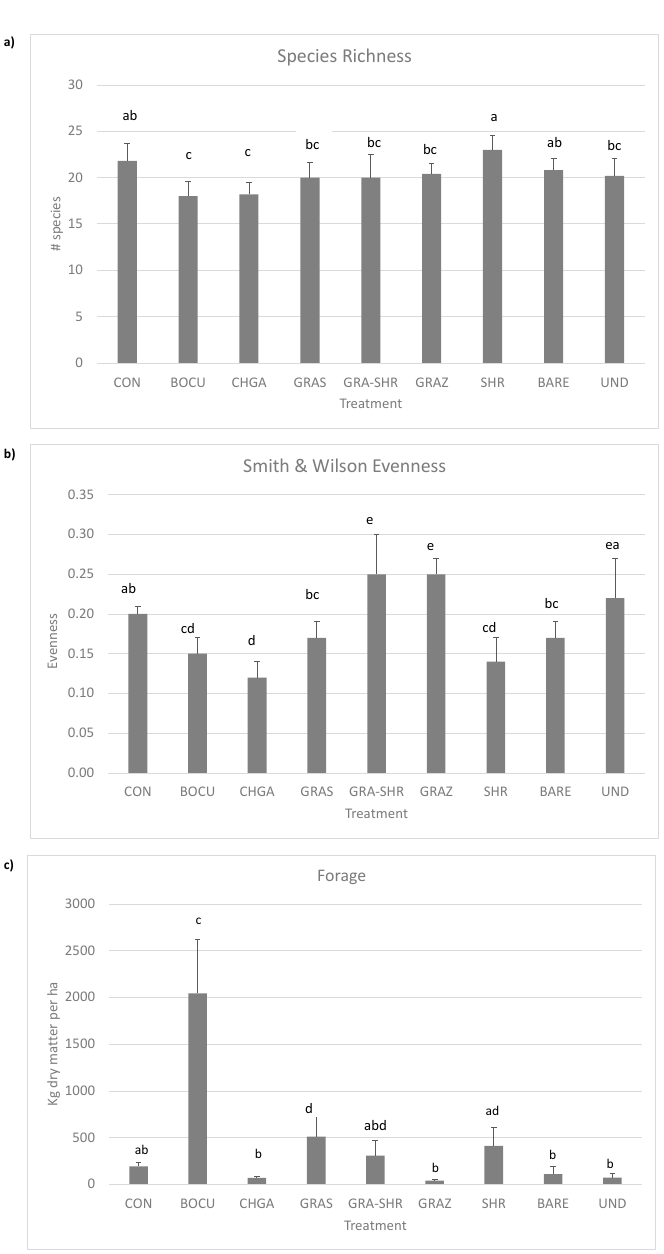
Figure 1. Mean values and standard deviations for ( a ) species richness; ( b ) evenness, and ( c ) forage production/ha of the different groups for the different treatments. Identical letters on top of bars indicate nonsignificant differences ( p < 0.05 for d.f. = 36 for the error term).